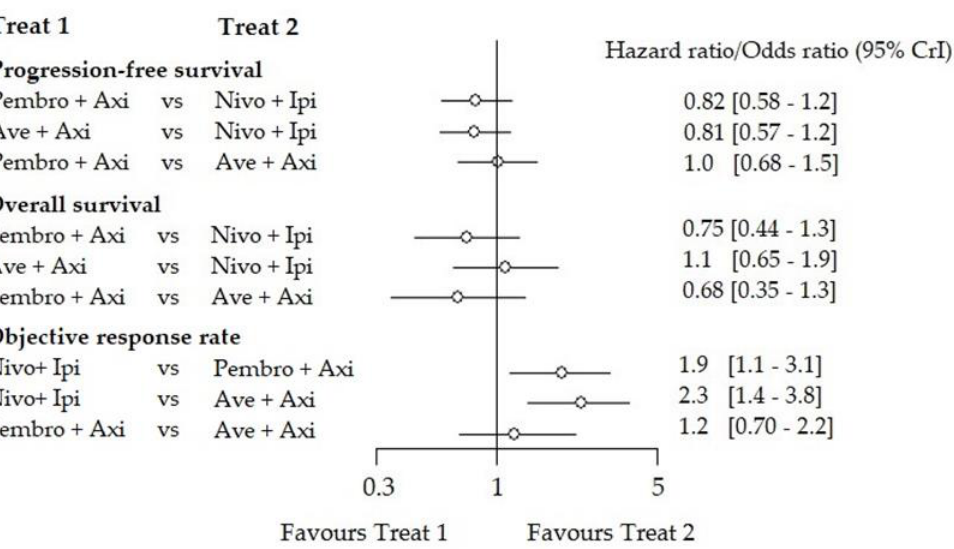
Figure 2. Indirect comparison of the contrast-based network meta-analysis (NMA) (fixed e ff ect) in the ITT) population. Forest plot of the indirect comparison between each combination for the 3 outcomes in the ITT population. For the ORR, the odds ratio favoring treatment 1 Treat 1, means that treatment 1 had a lower response rate than treatment 2 (Treat 2).